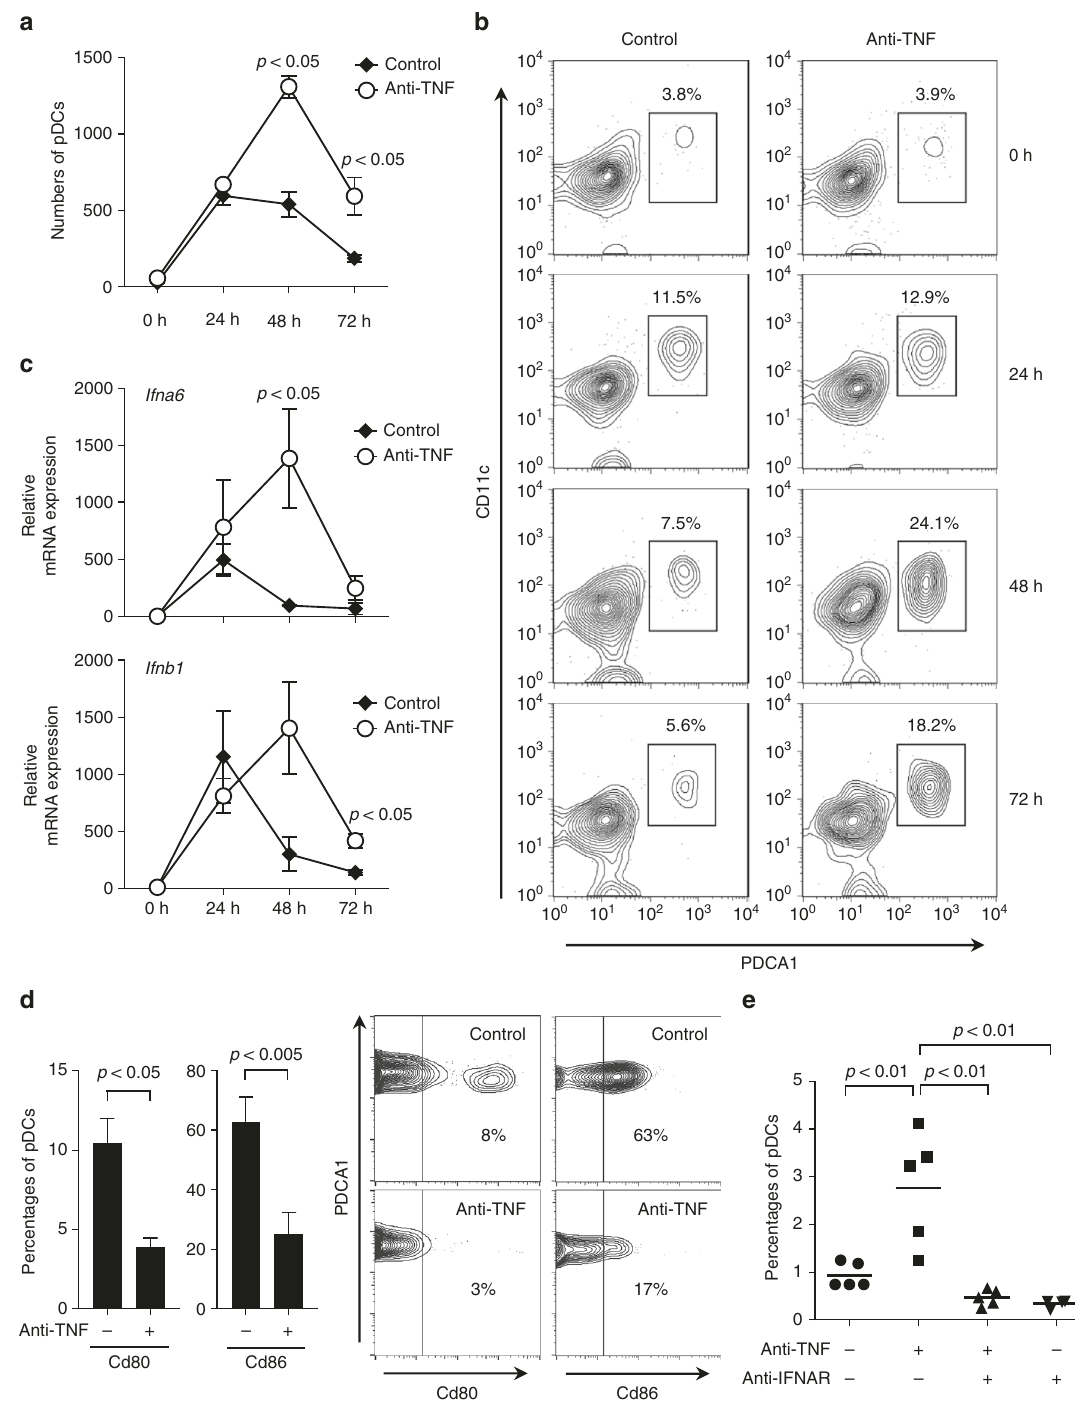
Fig. 4 Effect of anti-TNF treatment on plasmacytoid dendritic cell (pDC)-activation in skin. a pDC numbers in fi ltrating the skin upon mechanical injury of the back of mice treated with or without anti-TNF. pDCs quanti fi ed by fl ow cytometry at indicated time points. b One representative contour plot for each group at indicated time points. c Total skin mRNA expression of the type I interferons Ifna6 and Ifnb1 upon mechanical injury of mice treated with or without anti-TNF at indicated time points. d Expression of co-stimulatory molecules Cd80 and Cd86 on skin-in fi ltrating pDCs 48 h after mechanical skin injury of mice treated with or without anti-TNF. e Percentage of pDCs in fi ltrating the skin of mice upon mechanical injury in the presence or absence of anti-TNF and/or anti-IFNAR antibodies. Experiment depicted in a and c is representative for at least three independent experiments using at least three mice per group. Bar charts in d show mean values plus SEM of six mice, with pDCs from skin of two mice pooled for each data point; one representative contour plot for each group (two mice pooled) is depicted in the right panel d . All statistical analyses were performed with unpaired Student ’ s t